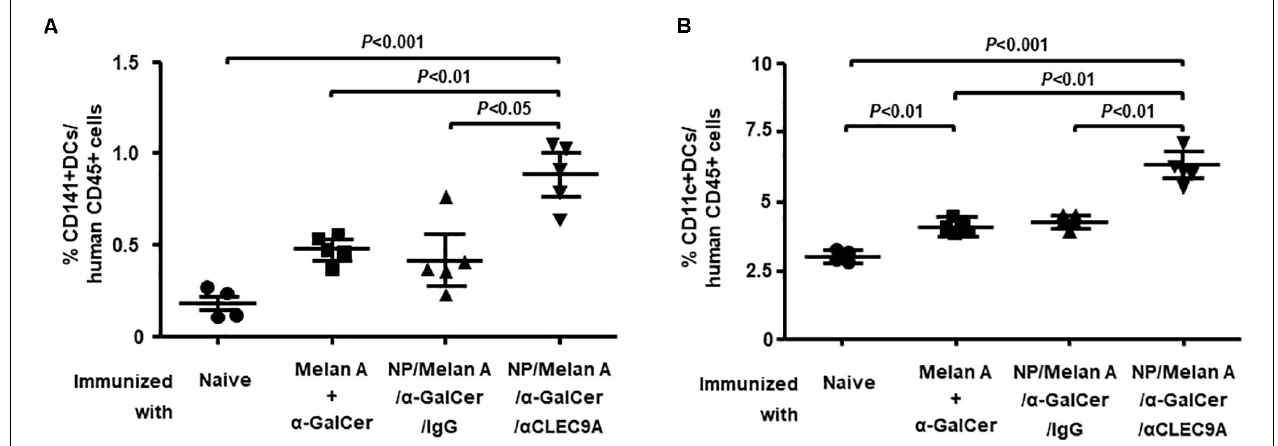
FIGURE 4 | Expansion of human DC subsets by NP-Melan-A vaccines. (A) The percentage of CD141 + human DCs among mouse CD45 + cells within splenocytes isolated from immunized HIS-CD8/NKT mice was determined by flow cytometry. (B) The percentage of CD11c + human DCs among CD45 + cells within splenocytes isolated from immunized HIS-CD8/NKT mice was determined by flow cytometry. Results are displayed as the mean value and standard error ( n = 5). Statistical analyses were performed using ANOVA followed by Dunnett’s test and differences were considered if P < 0.05.